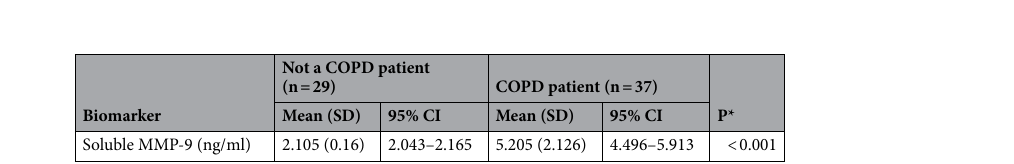
Table 4. Differences in soluble levels of MMP-9 in COPD patients and non-COPD patients. *Independent sample t test.